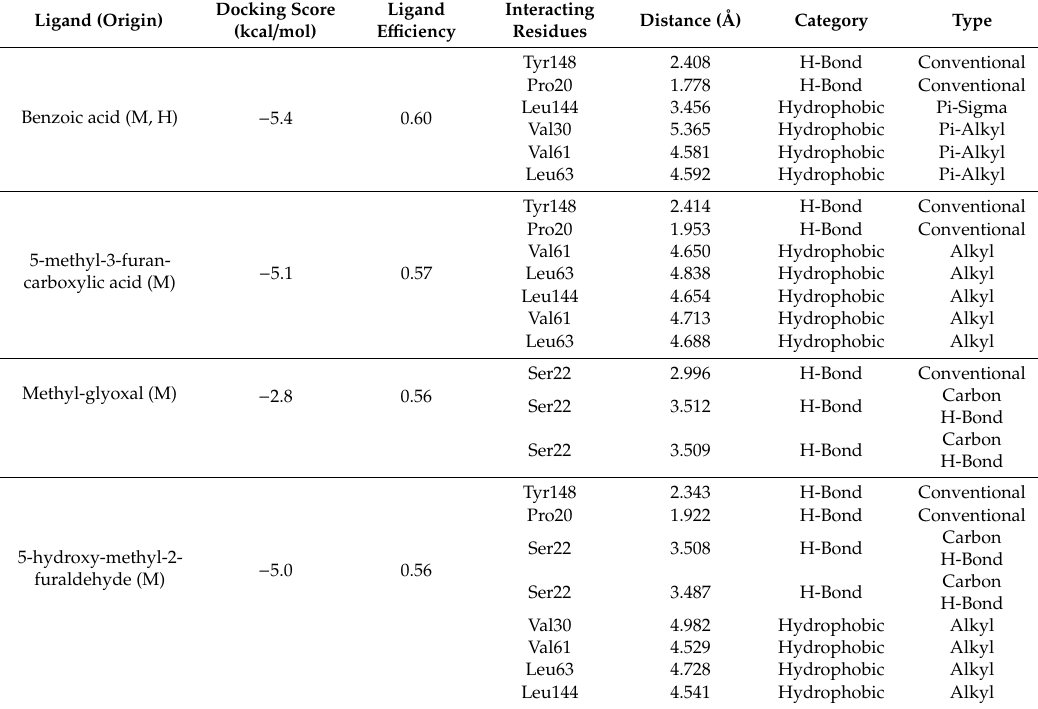
Table 1. Molecular interactions of Manuka (M) / Heather (H) honey constituents showing the best ligand e ffi ciencies for Pa DsbA1 1 .